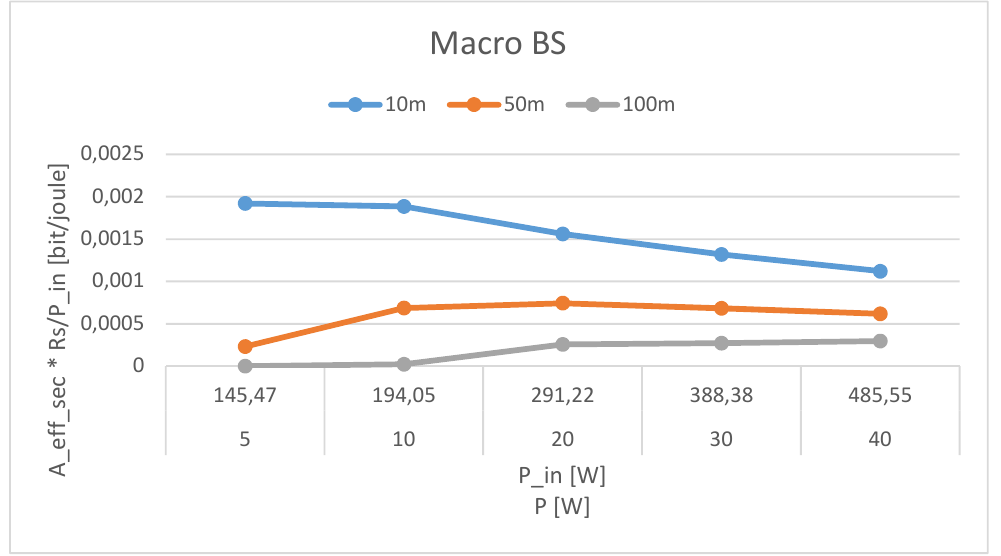
Figure 7. Effective Secrecy-Energy Efficiency as a function of the power consumption P in for different distances of the legitimate receiver { 10,50,100 } m. The corresponding radiated power P is reported in the x -axis under the P in value. The power consumption is referred to a Macro